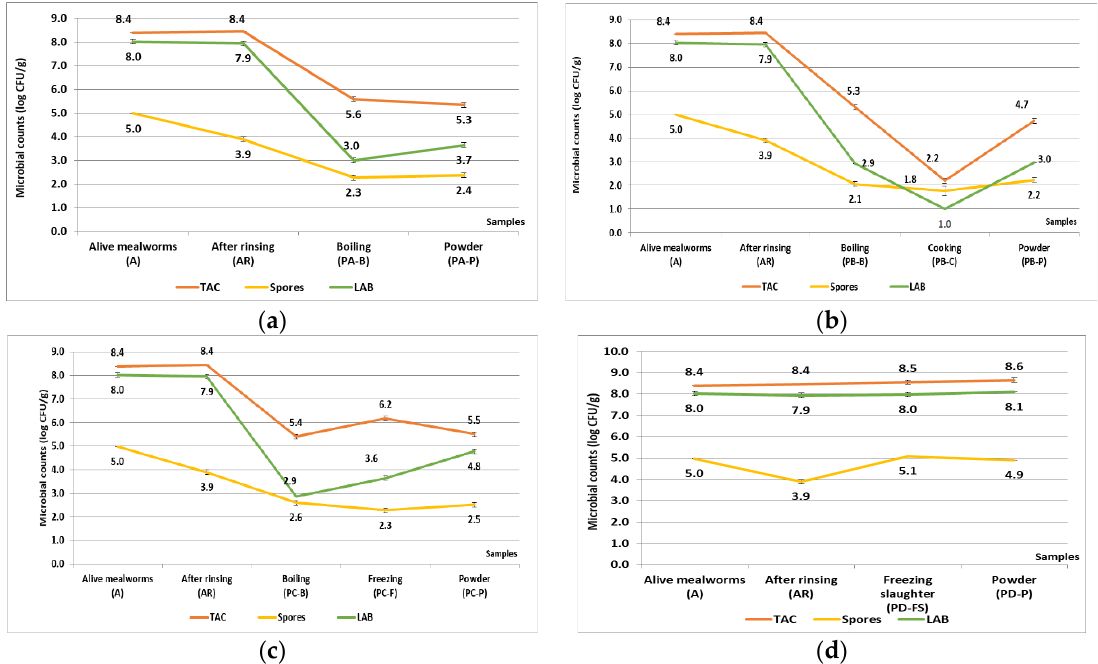
Figure 2. Microbial counts variation of processing pathway A ( a ), pathway B ( b ), pathway C ( c ), pathway D ( d ) (TAC: total aerobic viable count; spores: bacterial endospores; LAB: lactic acid bacteria; data are mean values of two batches).